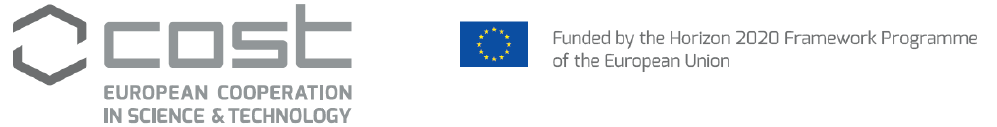
Table A1. Logistic regression predicting PEM presence.